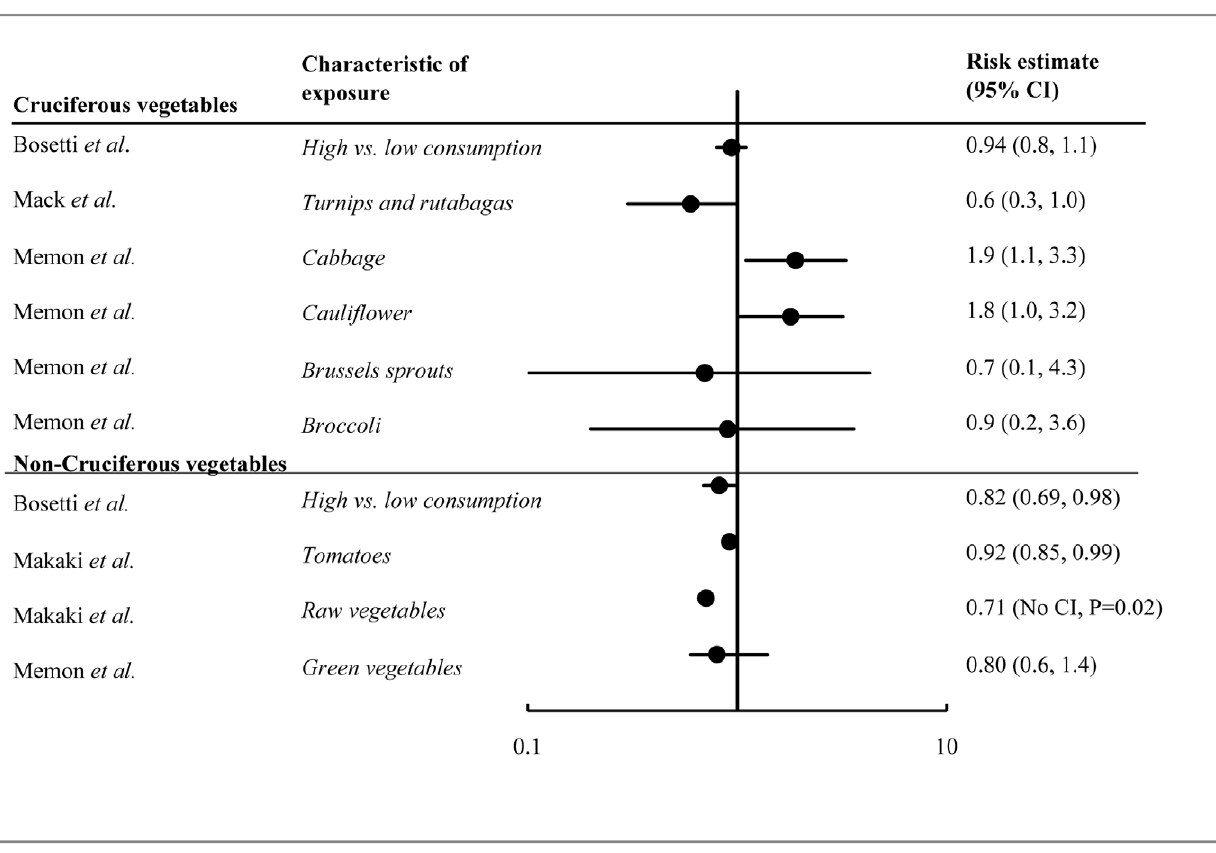
Figure 4. Forest plot of risk estimates for thyroid cancer from consumption of cruciferous and non-cruciferous vegetables. A meta- analysis of the data was not performed due to the heterogeneity of the methods and risk factor definitions across studies. Notable differences in study characteristics and study samples are indicated on the plot.